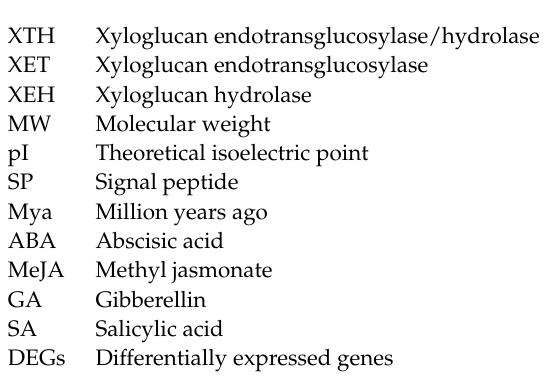
flowering stages; Table S6: The RT-qPCR raw data of five differential expressed OfXTH genes treated at 19 ◦ C and 23 ◦